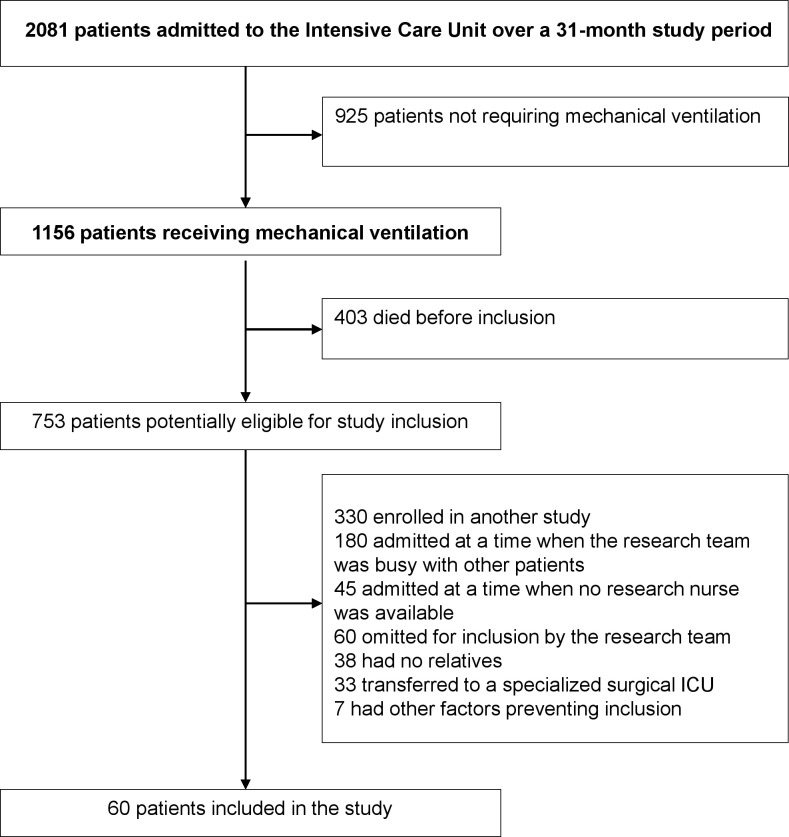
Study flow diagram.